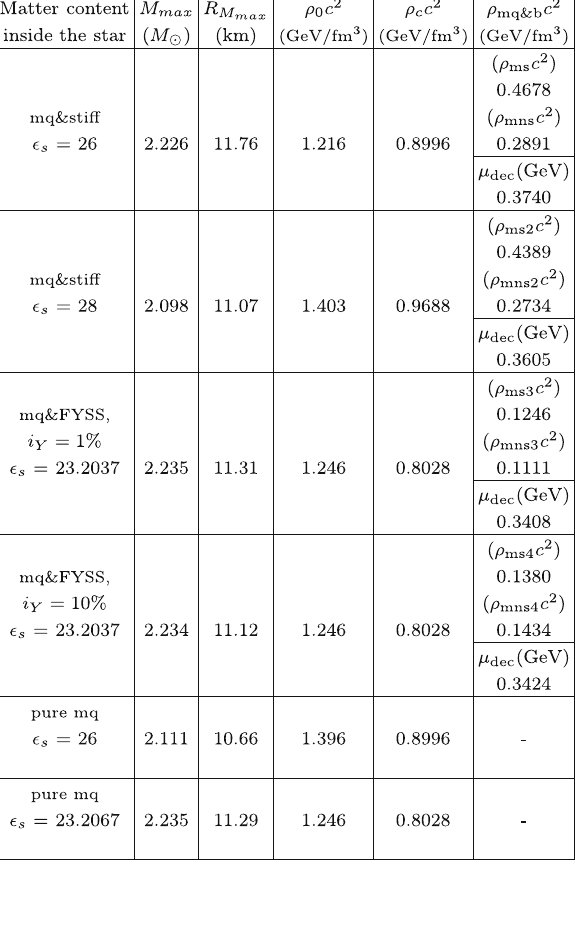
Table 1 Properties of massive neutron stars with multiquark cores (